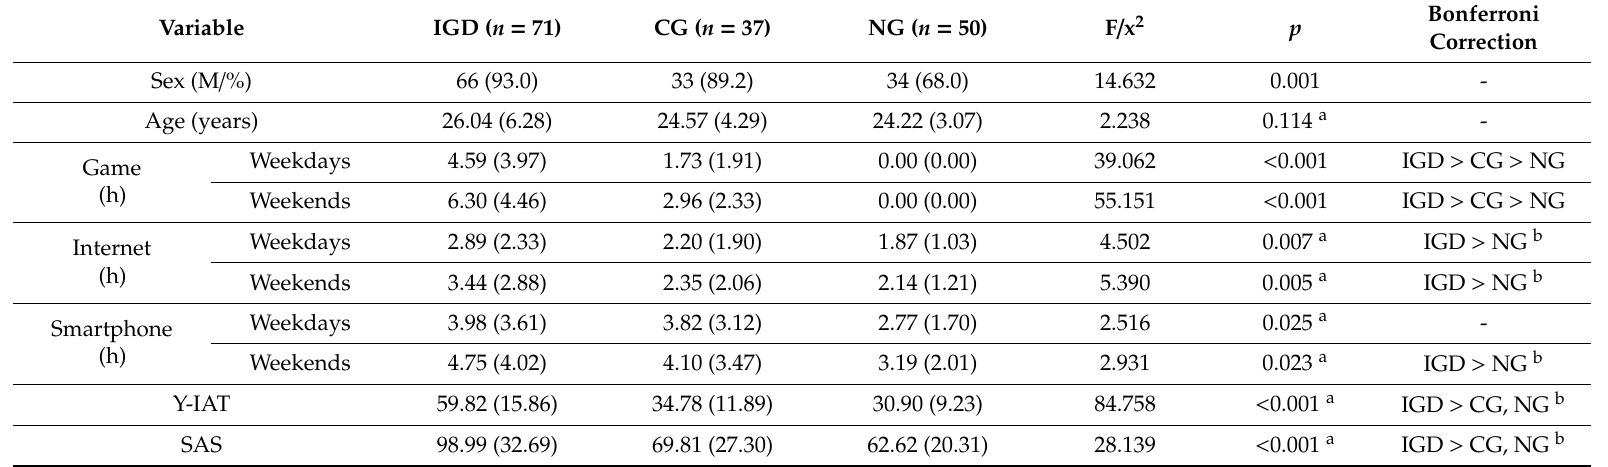
Table 1. Comparison of demographic characteristics among